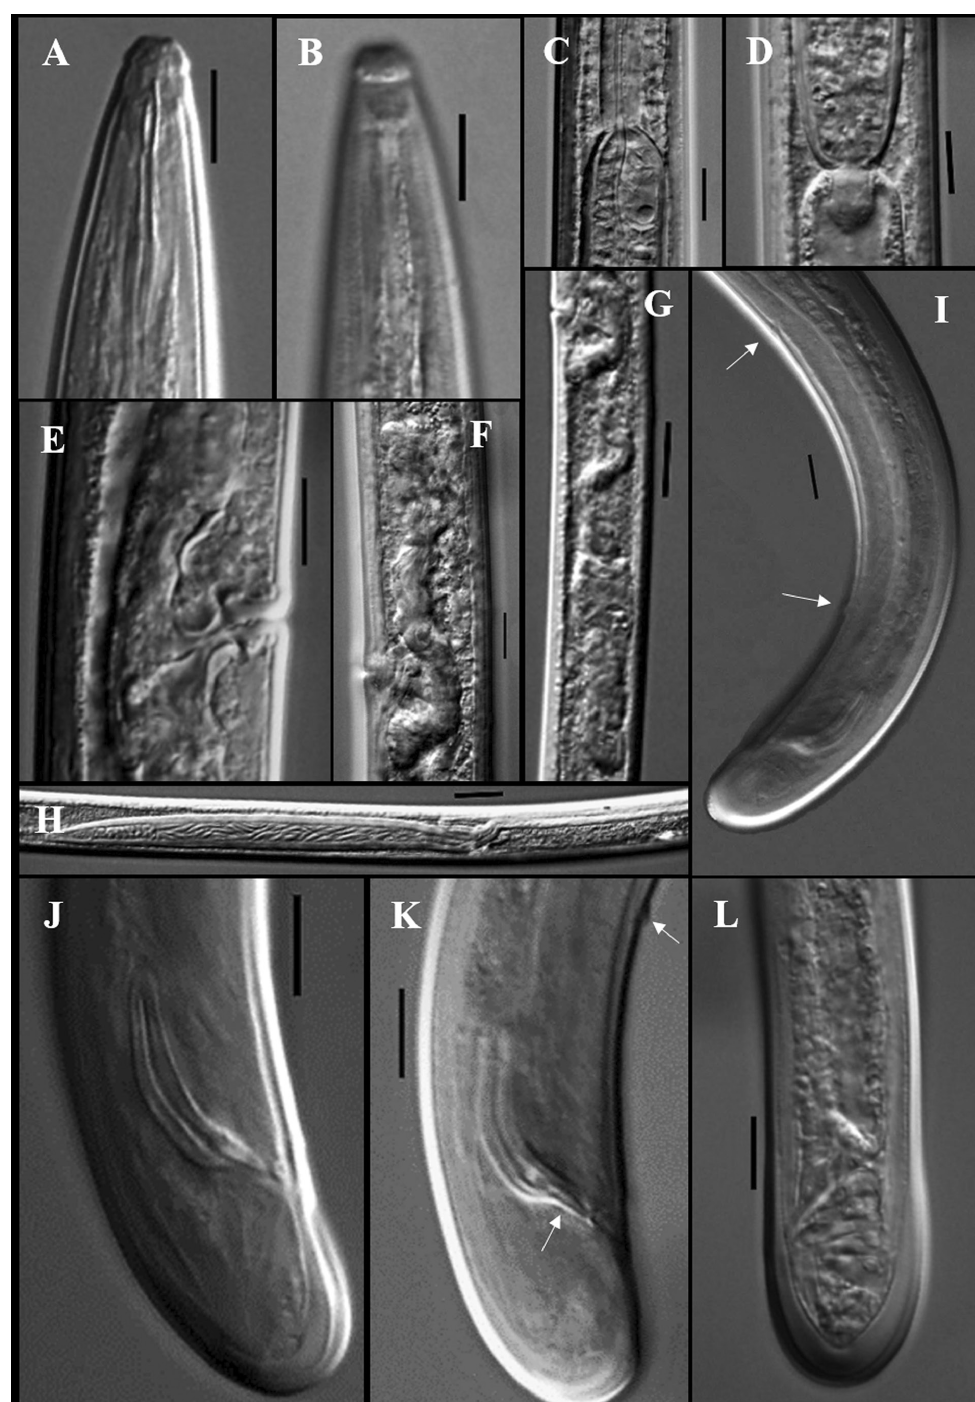
Fig. 8. Axonchium microspiculum sp. nov. (LM photographs). A – G , L . Holotype, ♀ (slide 1). H – K . Paratype 4, ♂ (slide 2). A . Anterior region. B . Anterior end showing amphid. C . Junction between two parts of the pharynx. D . Cardia. E . Vulva and vagina. F – G . Female genital branches. H . Male testes. I . Ventromedian supplements. J . Male posterior end. K . Arrows showing lateral guiding piece and first ventromedian supplement. L . Female posterior end. Scale bars: A–G, I–L = 10 µm; H = 20